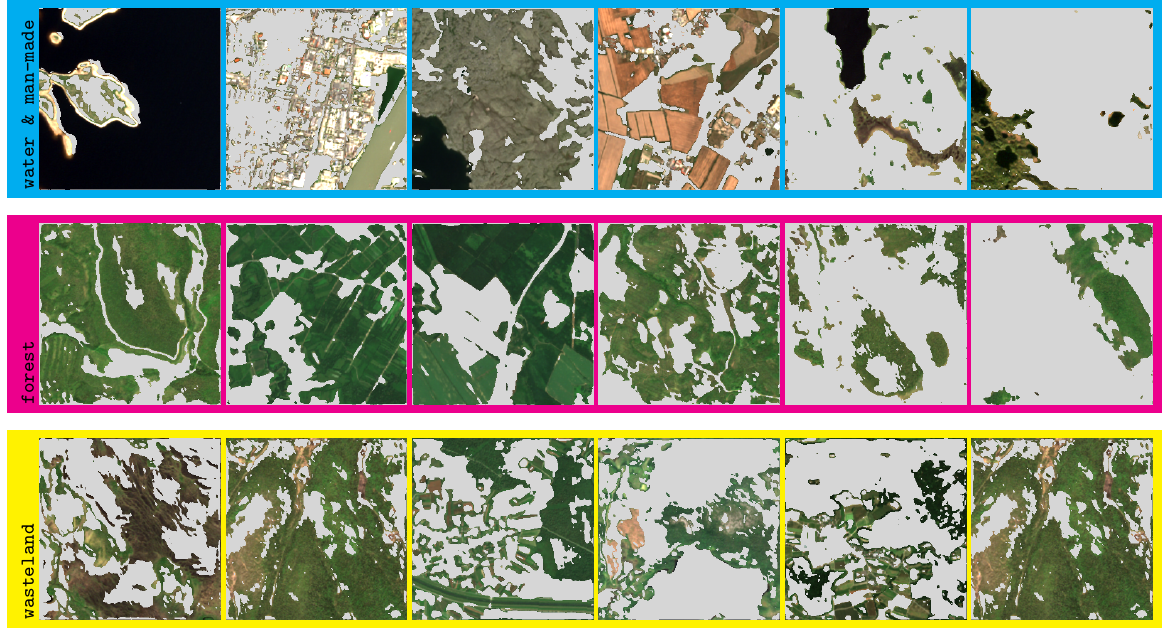
Figure 8. Correctly classified samples for each of the potential concepts. Colored areas correspond to given concepts, and gray areas are part of other concepts. Water & man-made : The first four samples show highly sensitive areas, which means areas that are highly connected to the non-wilderness class. The last two samples show non-sensitive areas of the same concept. Forest : Again, the first four areas are highly connected to non-wilderness , while the last two areas are non-sensitive. Wasteland : The first three samples show areas that are slightly connected to wilderness , whereas the last three areas are slightly connected to non-wilderness . In this paper, we used protected areas as a weak label proxy for wilderness , but also other classes can be used as a proxy.